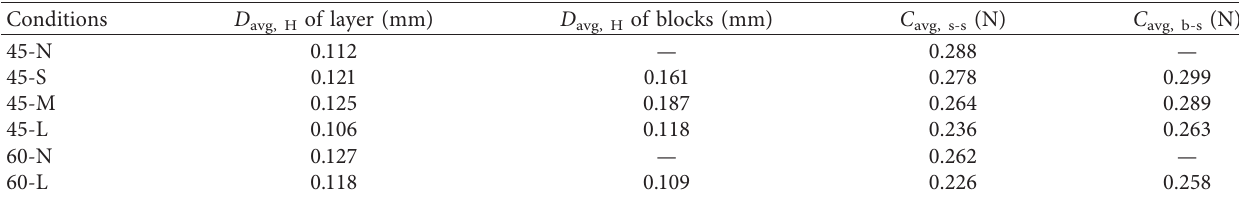
Figure 16: Displacement of soil slopes with blocks under FH effect (unit: m). (a) 45-N, (b) 45-S, (c) 45-M, (d) 45-L, (e) 60-N, and (f) 60-L. Note: 45-N, 45-S, 45-M, 45-L, 60-N, and 60-L mean 45 ° slope without a block, 45 ° slope with a small block, 45 ° slope with a medium block, 45 ° slope with a large block, and 60 ° slope without a block, and 60 ° slope with a large block, respectively. Table 7: Average displacement and average contact force of particles and blocks in the frozen